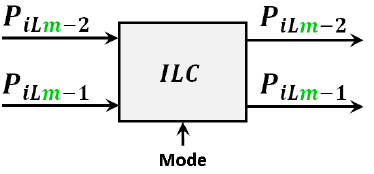
Figure 5. Block diagram of the programmed model of the ILC.